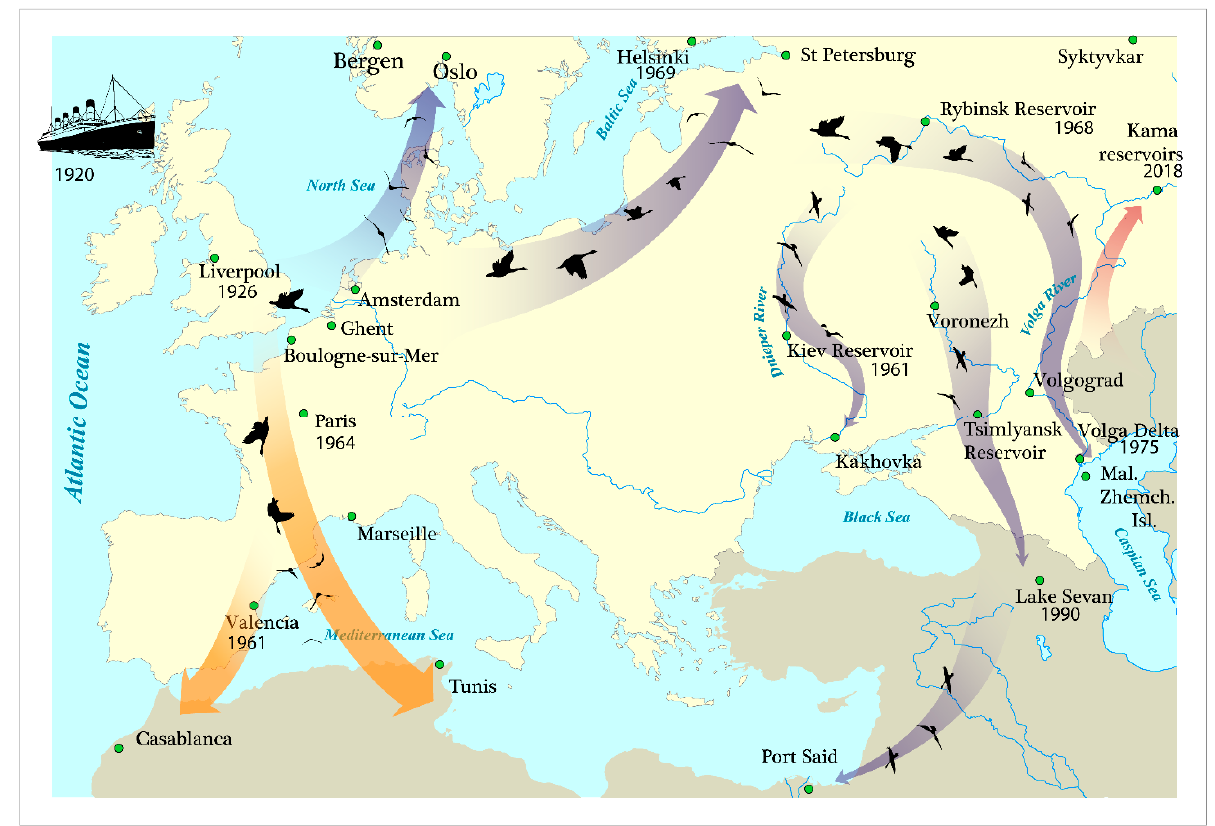
Figure 6. Illustration of the mechanism of distribution of Acanthocyclops americanus with waterfowl along the main routes of migration.